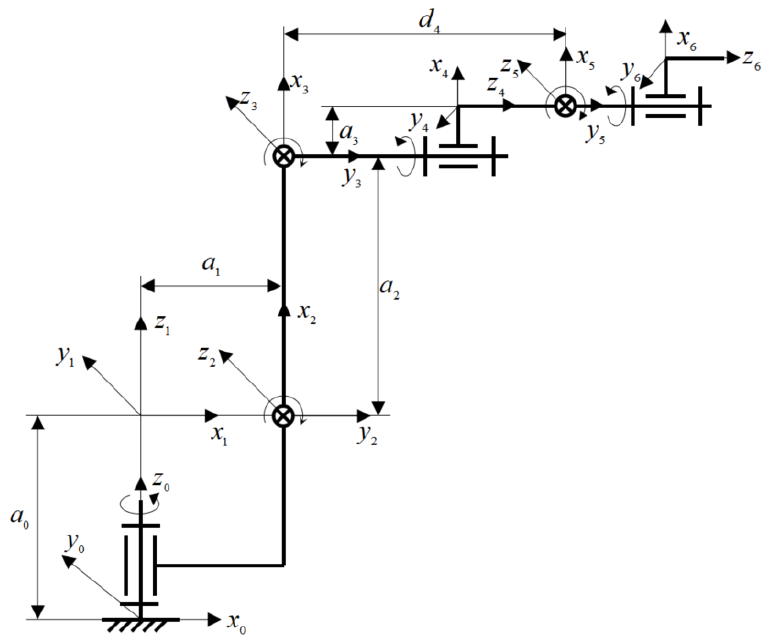
Figure 5. Schematic diagram of manipulator coordinate system.